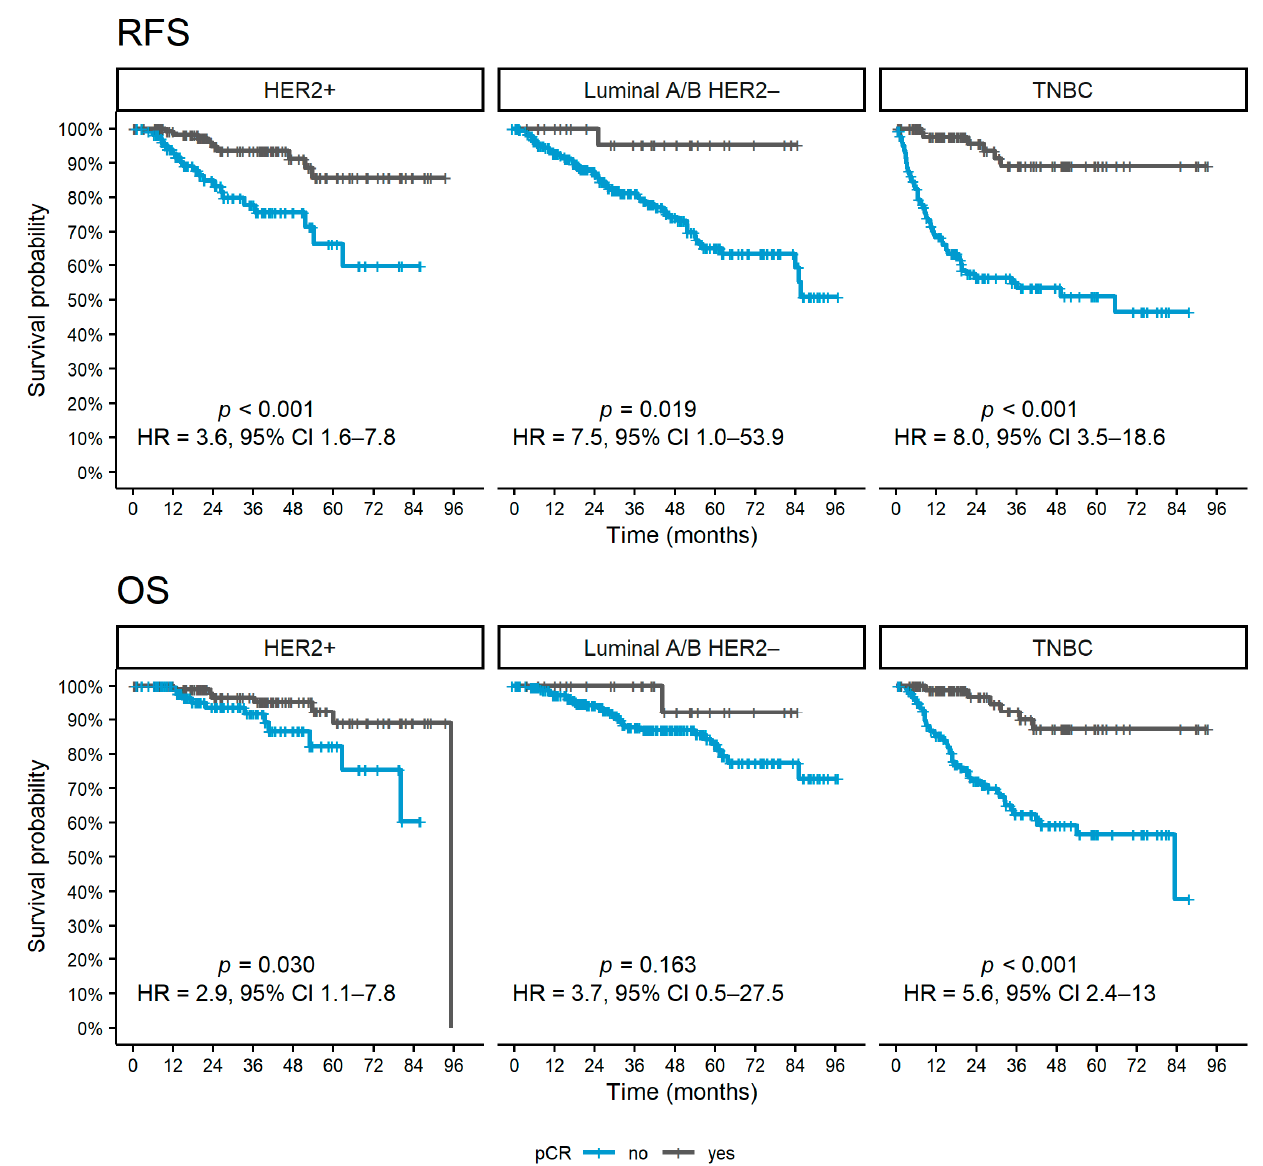
Figure 2. Kaplan–Meier curves of survival outcomes according to pCR achievement for each subtype. Abbreviations: pCR, pathological complete response; OS, overall survival; RFS, relapse-free survival; HR, hazard ratio; CI, confidence interval; TNBC, triple-negative breast cancer; HER2, human epidermal growth factor receptor 2.